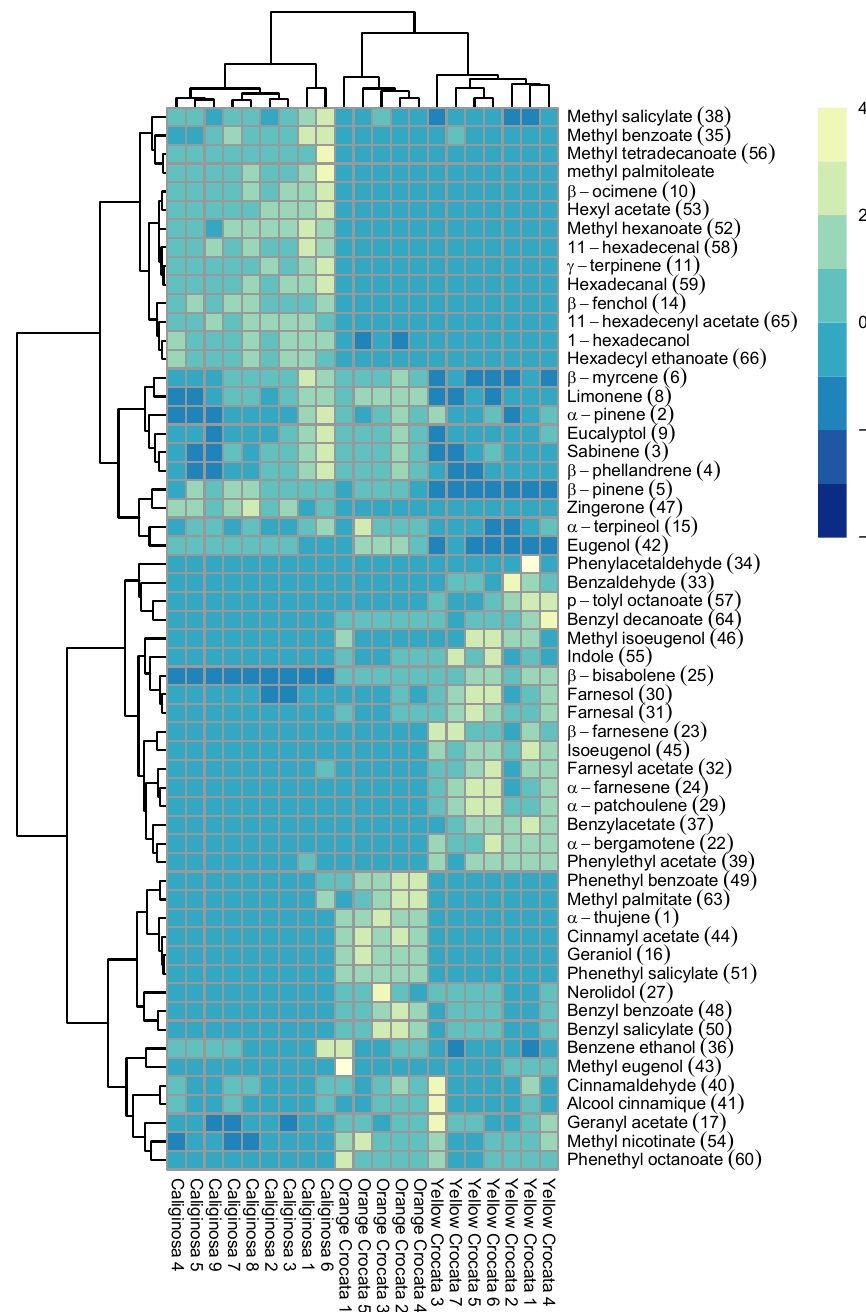
Figure 4. Heatmap, the levels of each VOC in the three types of flowers were normalized in the range of − 4 to 4. Blue ( − 4) and yellow (4) represent the lowest and highest levels,